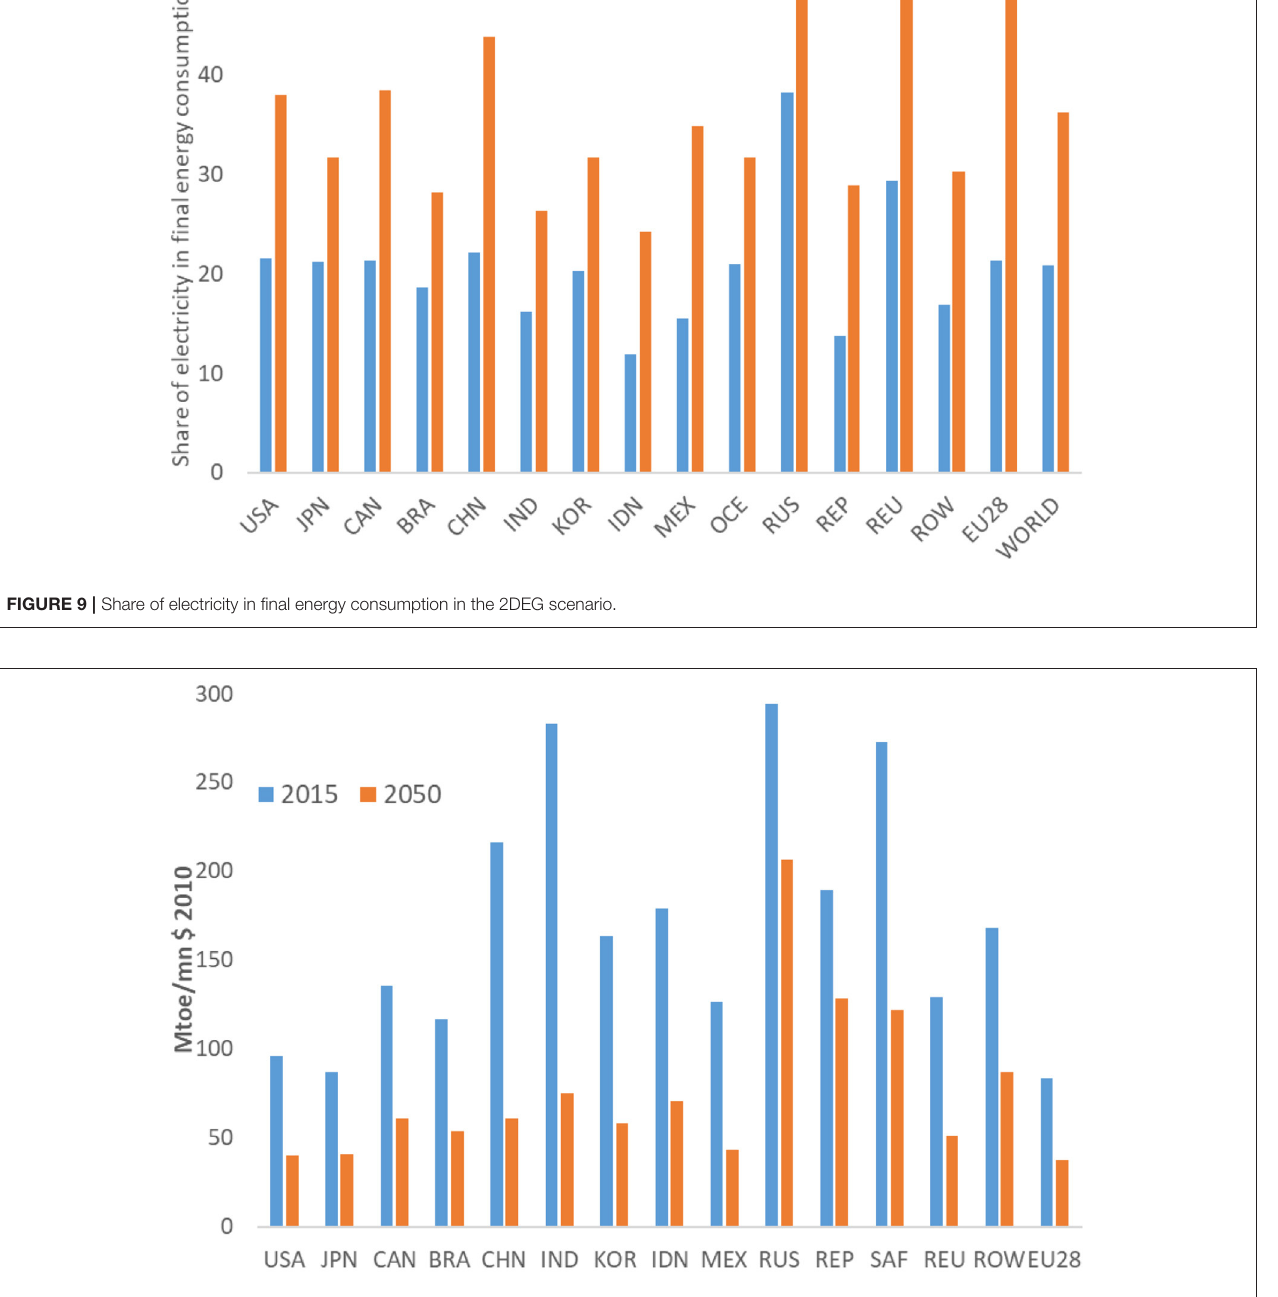
effects in the CGE context and weakened competitiveness in international markets; thus, resulting in reduced mitigation